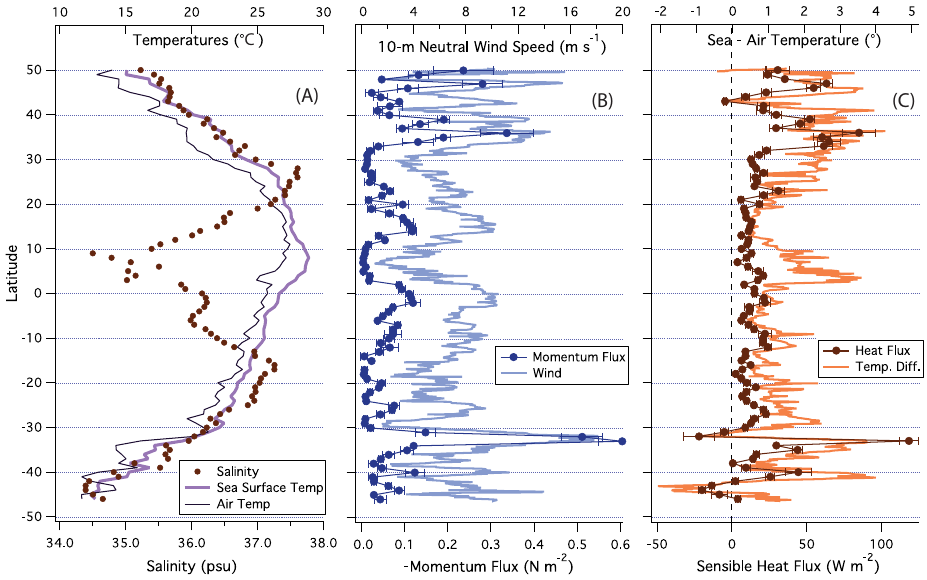
Figure 4. (A) Sea surface temperature, air temperature, and salinity (B) Wind speed and negative momentum flux; (C) Air–sea temperature difference and sensible heat flux. Sensible heat flux was usually from sea-to-air, except for short periods preceding storms near the beginning and end of the cruise. Error bars on fluxes correspond to standard errors.